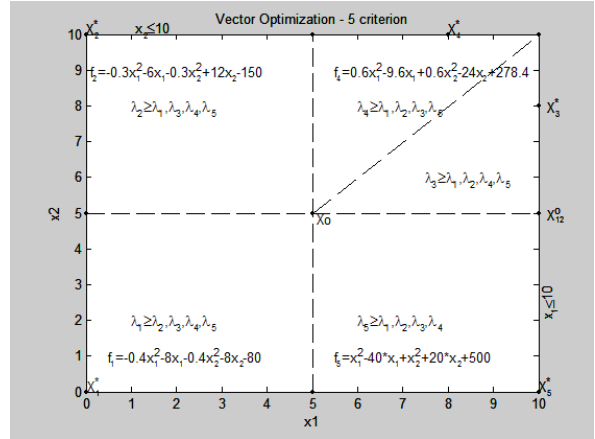
Figure 4. The solution of the vector problem of Equations (53) – (55).